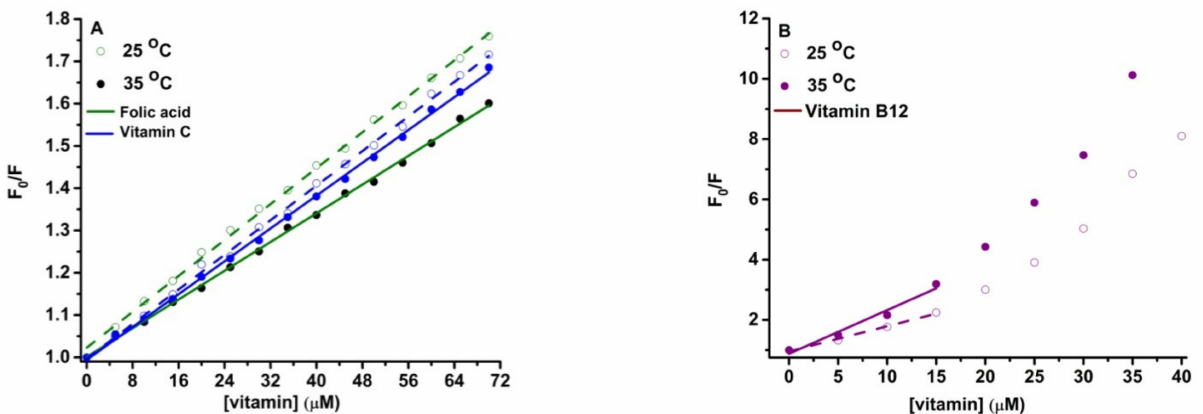
Figure 3. The Stern-Volmer representation of F0/F vs. [vitamin] for BSA-LT4/vitamin C, and BSA- LT4/folic acid complexes ( A ) and for the BSA-LT4/vitamin B12 ( B ) at 25 ◦ C (empty circles) and 35 ◦ C (full